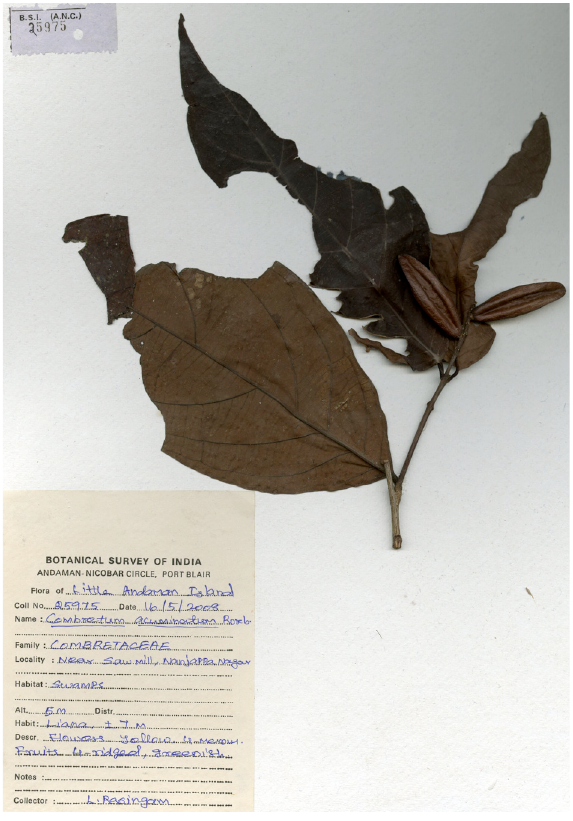
Image 3. Herbarium image of Combretum